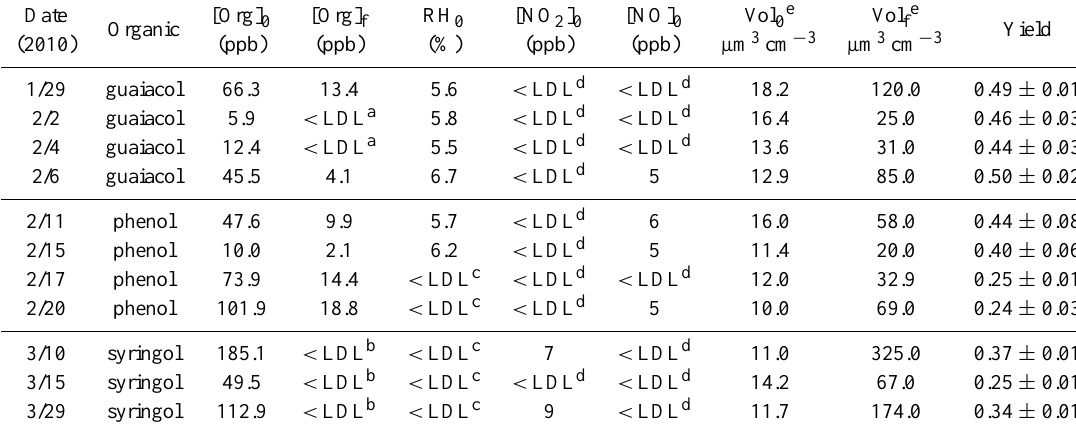
Table 2. Experimental conditions and aerosol yields. Date